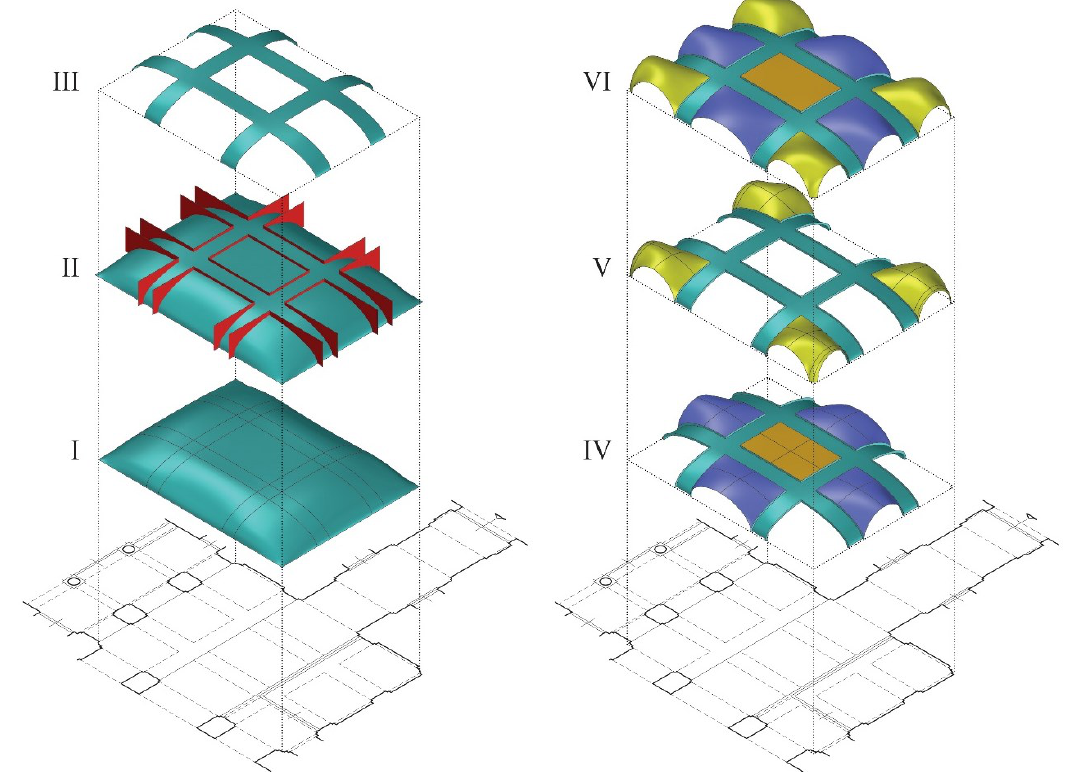
Figure 14. Decomposition of the 3D model of the vault design shape. Modelling: F.